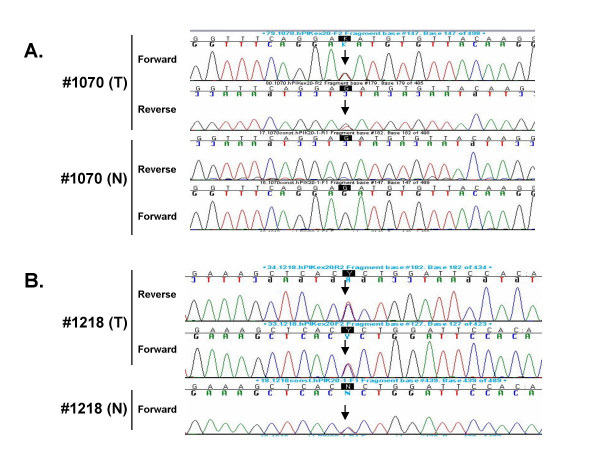
Detection of PIK3CA mutations. Chromatogram tracing for exon 20 sequences encoding the catalytic kinase domain in primary neuroblastomas #1070 (A) and #1218 (B). Sequences demonstrate heterozygous alterations in these tumor samples as depicted by the arrows, with the amino acid change for #1070 being GAG (glutamic acid) to GAT (representing GAU, aspartic acid). Alterations were confirmed bi-directionally and in replicate sequencing. T, tumor DNA sequence; N, normal (or constitutional) DNA sequence. Note the tumor-specific (somatic) mutation in #1070, whereas the alteration in the 3'-UTR in #1218 is present in both tumor and constitutional DNA and likely represents a rare polymorphic variant.